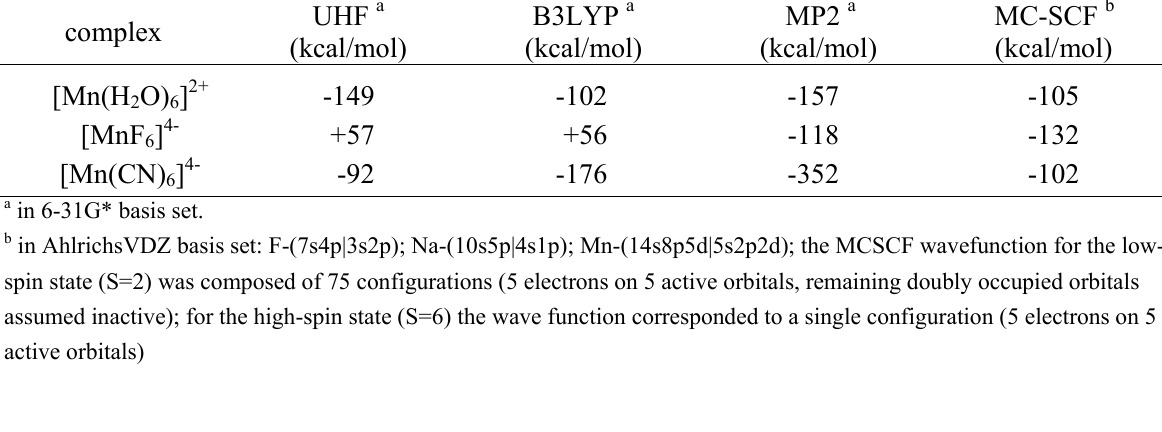
Table 1. Energy difference between high-spin and low-spin states of MnX calculation methods; ∆ E=E(high-spin) –